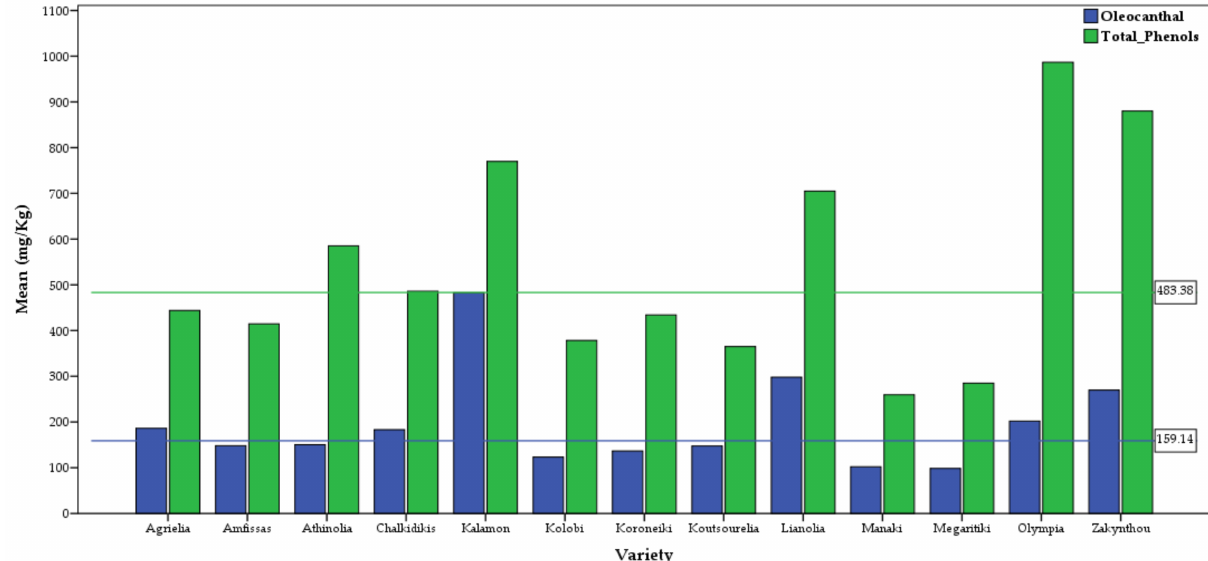
Figure 7. Difference in concentration of oleocanthal and total phenols in relation to variety (the horizontal green and blue lines represent the overall mean of oleocanthal and total phenols,